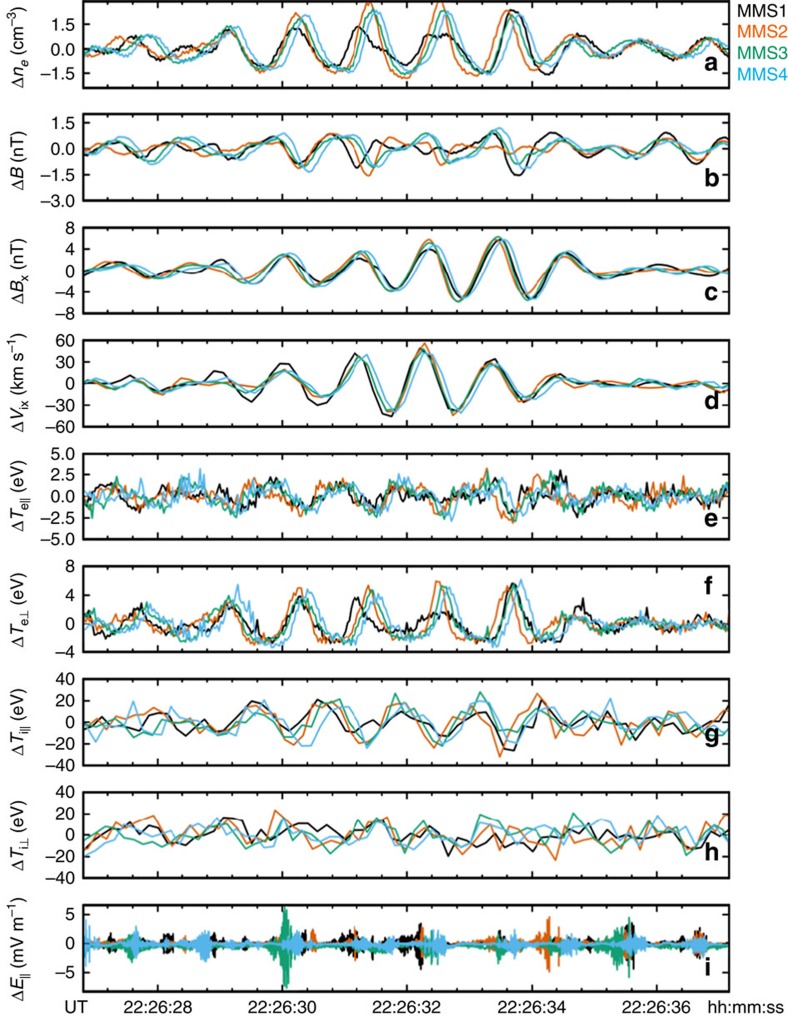
MMS observations of a KAW packet.Plasma parameters measured by the four MMS observatories on 30 December 2015 in a KAW packet. (a,b) Compressive fluctuations are observed in anti-correlated electron density (Δne) and magnetic field magnitude (ΔB) measurements. (c,d) Positively correlated fluctuations are observed in near-transverse components of the magnetic field (ΔBX) and electron bulk velocity (ΔVex). (e–h) Fluctuations in both parallel and perpendicular temperature of both electrons (ΔTe) and ions (ΔTi) are shown, with the strongest relative fluctuations (∼10%) observed in the perpendicular electron temperature. (i) Bursts of electron-scale phase space holes measured in the parallel electric field (ΔE||) are bunched with the ion-scale KAW wave and correspond to some of the gradients in the measured electron pressure.